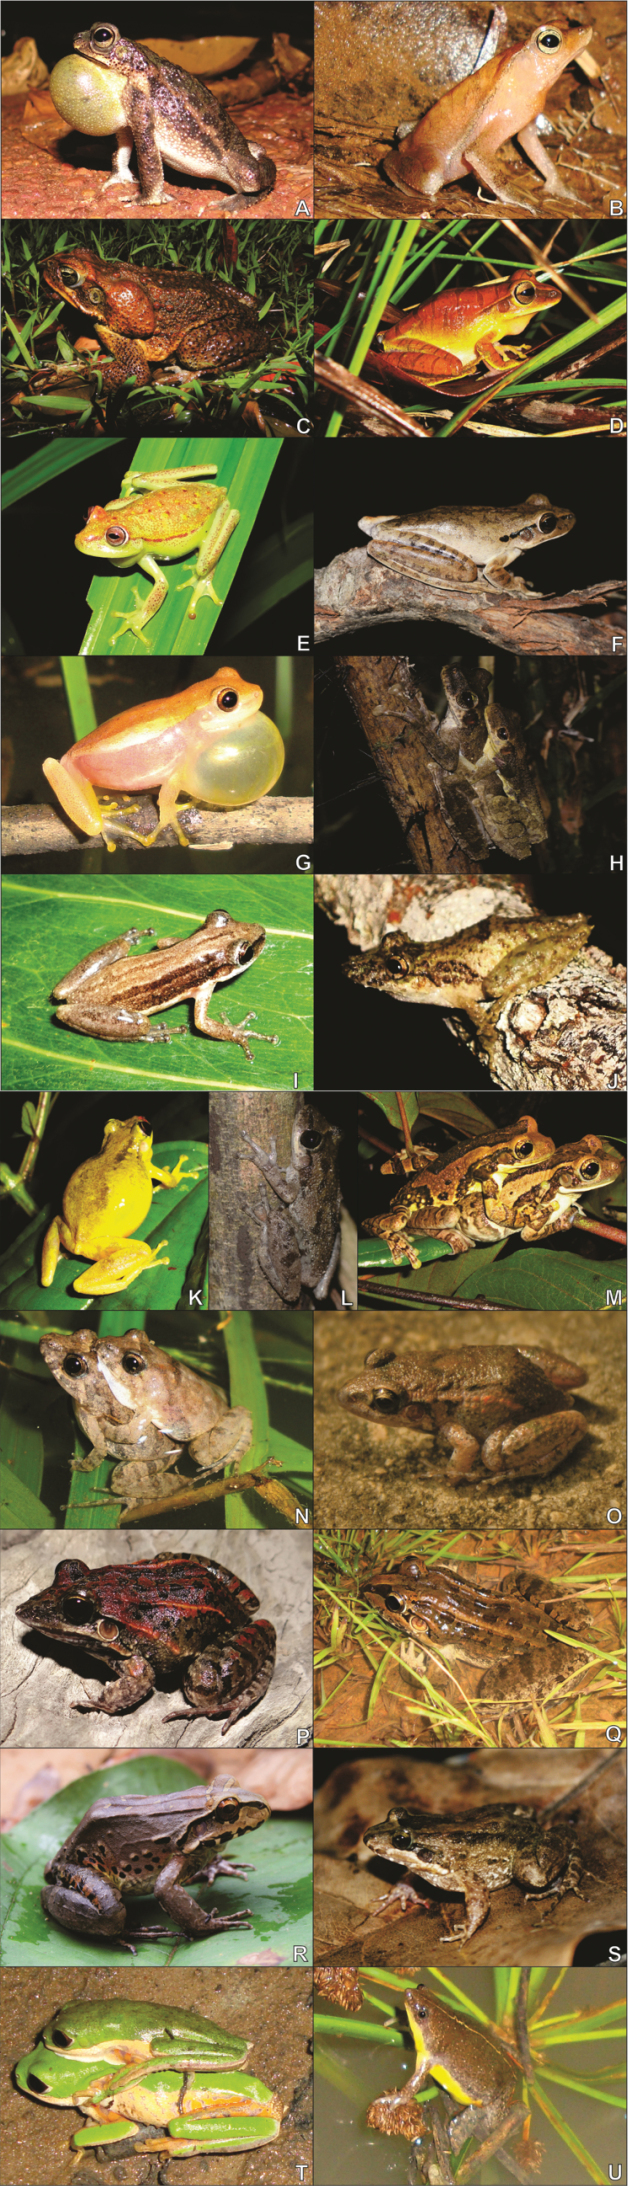
Anurans recorded in the savanna area from the Experimental Field of the Brazilian Agricultural Research Corporation – EMBRAPA, municipality of Macapá, Amapá State, northern Brazil: ARhinellamajorBRhinella sp. CR.marinaDBoanamultifasciataEB.punctataFB.ranicepsGDendropsophuscf.walfordiHOsteocephalustaurinusIScinaxfuscomarginatusJS.nebulosusKS.ruberLS.x-signatusMTrachycephalustyphoniusNPseudopaludicolabolivianaOAdenomerahylaedactylaPLeptodactylusfuscusQL.macrosternumRL.pentadactylusSL.podicipinusTPithecopushypochondrialis, and UElachistocleishelianneae.